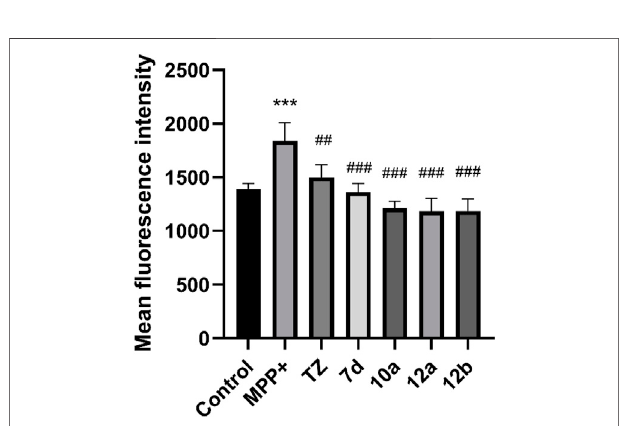
FIGURE 4 | Effect of target compounds on ROS level of SH-SY5Y cells injured by MPP + . Compounds were all at the concentration of 2.5 μ M and were tested under the same conditions. Values are means ± SD. Statistical signi fi cance was represented by *** p < 0.001 vs . control, ## p < 0.01 vs . MPP + group, ### p < 0.001 vs . MPP +